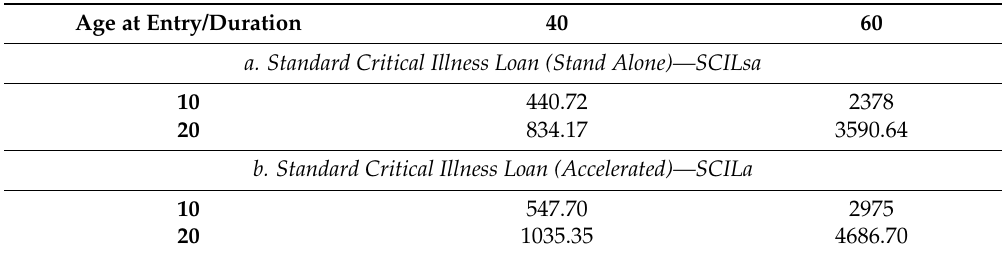
Table 6. Actuarial Periodic Premium—Male smokers. Issue Time 2014, r = 2%, i = 7%, C = 200,000.